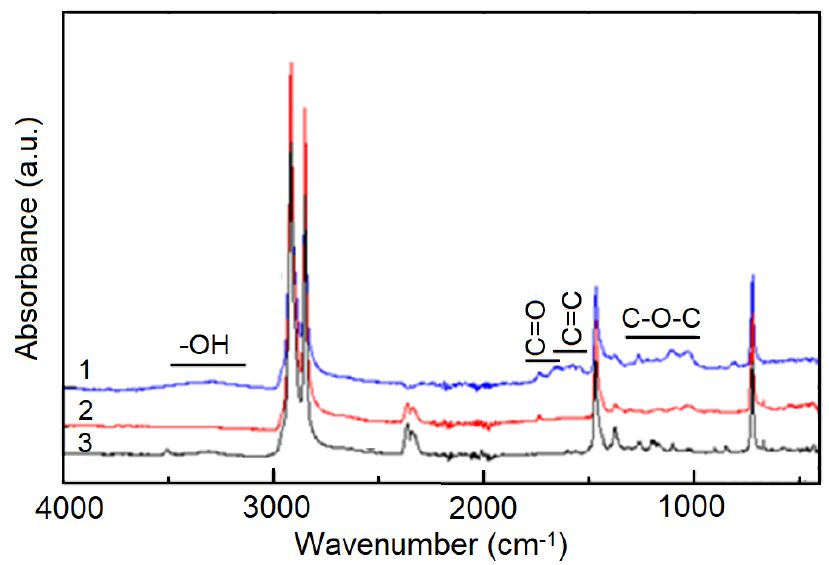
Figure 3. Melting endotherms from three different polyethylene materials: 1—XLPE insulation (from I&C cable); 2—LLDPE insulation (from multiconductor instrumentation); 3—HDPE insulation (from multiconductor instrumentation).